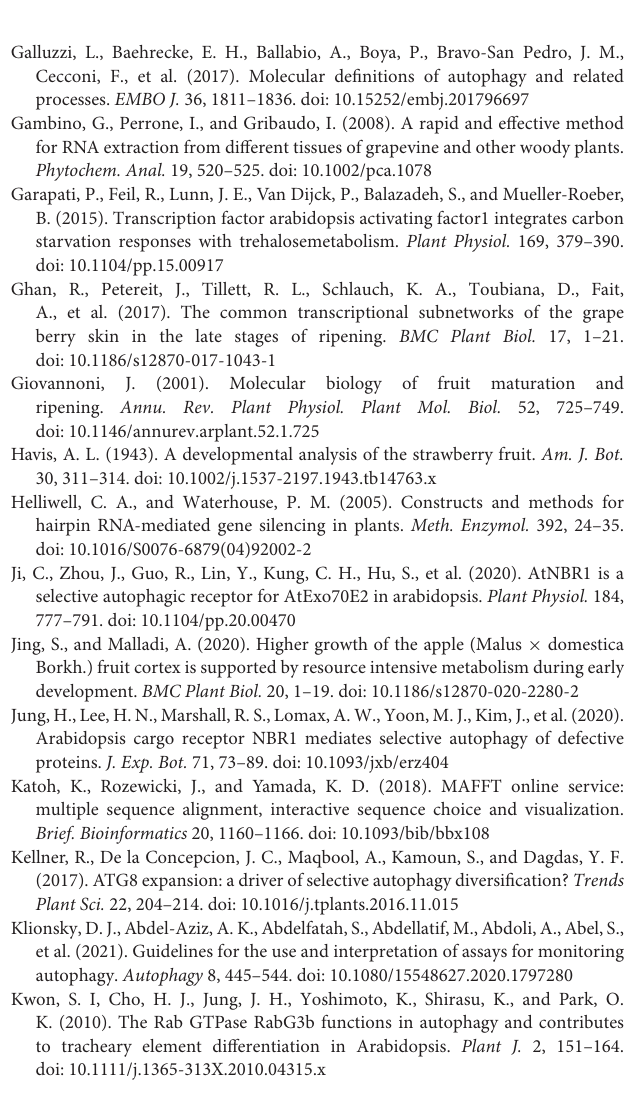
Supplementary Table 1 | (S1) List of primers used in this work. (S2) Autophagy related genes found in F. vesca genome. Supplementary Table 2 | Expression levels in FPKM of all autophagy-related genes analyzed in this work along ripening in F. x ananassa receptacle and